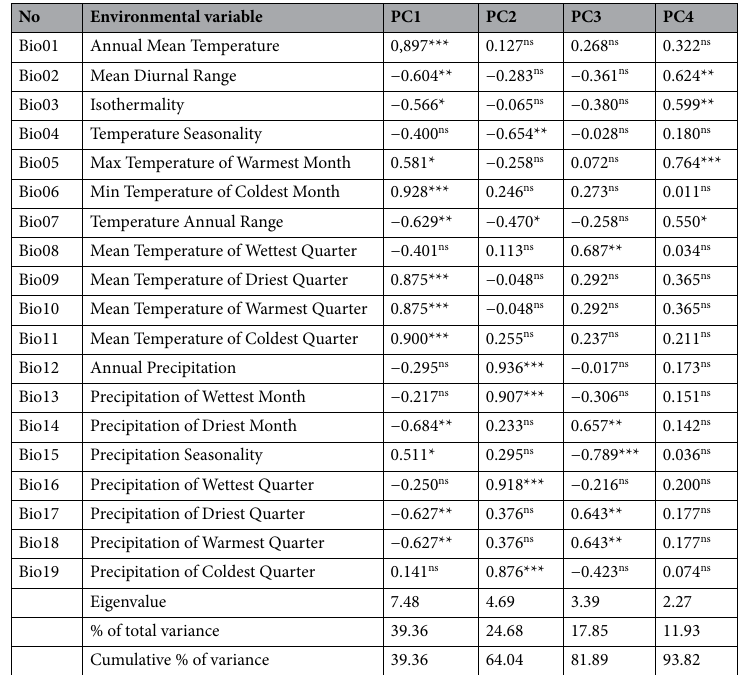
Table 2. Correlations between 19 environmental variables (Bio1–Bio19) and the first four principal components. Ns non-significant. *Significant at P < 0.05. **Significant at P < 0.01. ***Significant at P < 0.001.